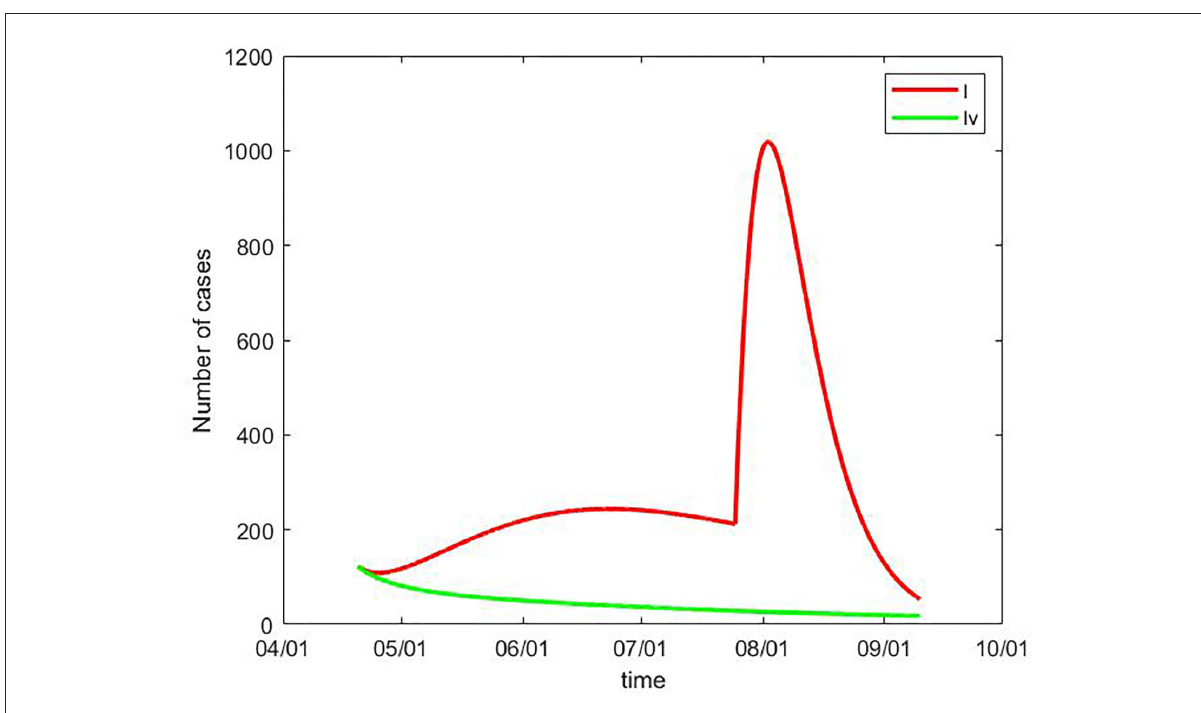
FIGURE2 Number of infectious people with vaccination I v (t) and without vaccination I(t) , China, 20 April to 10